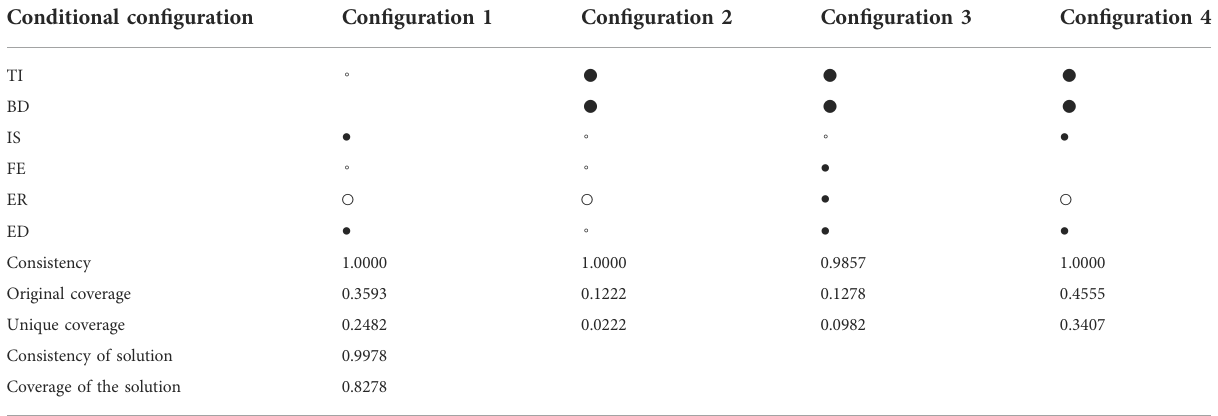
TABLE 7 Analysis of high-level circular economy performance con fi guration in western